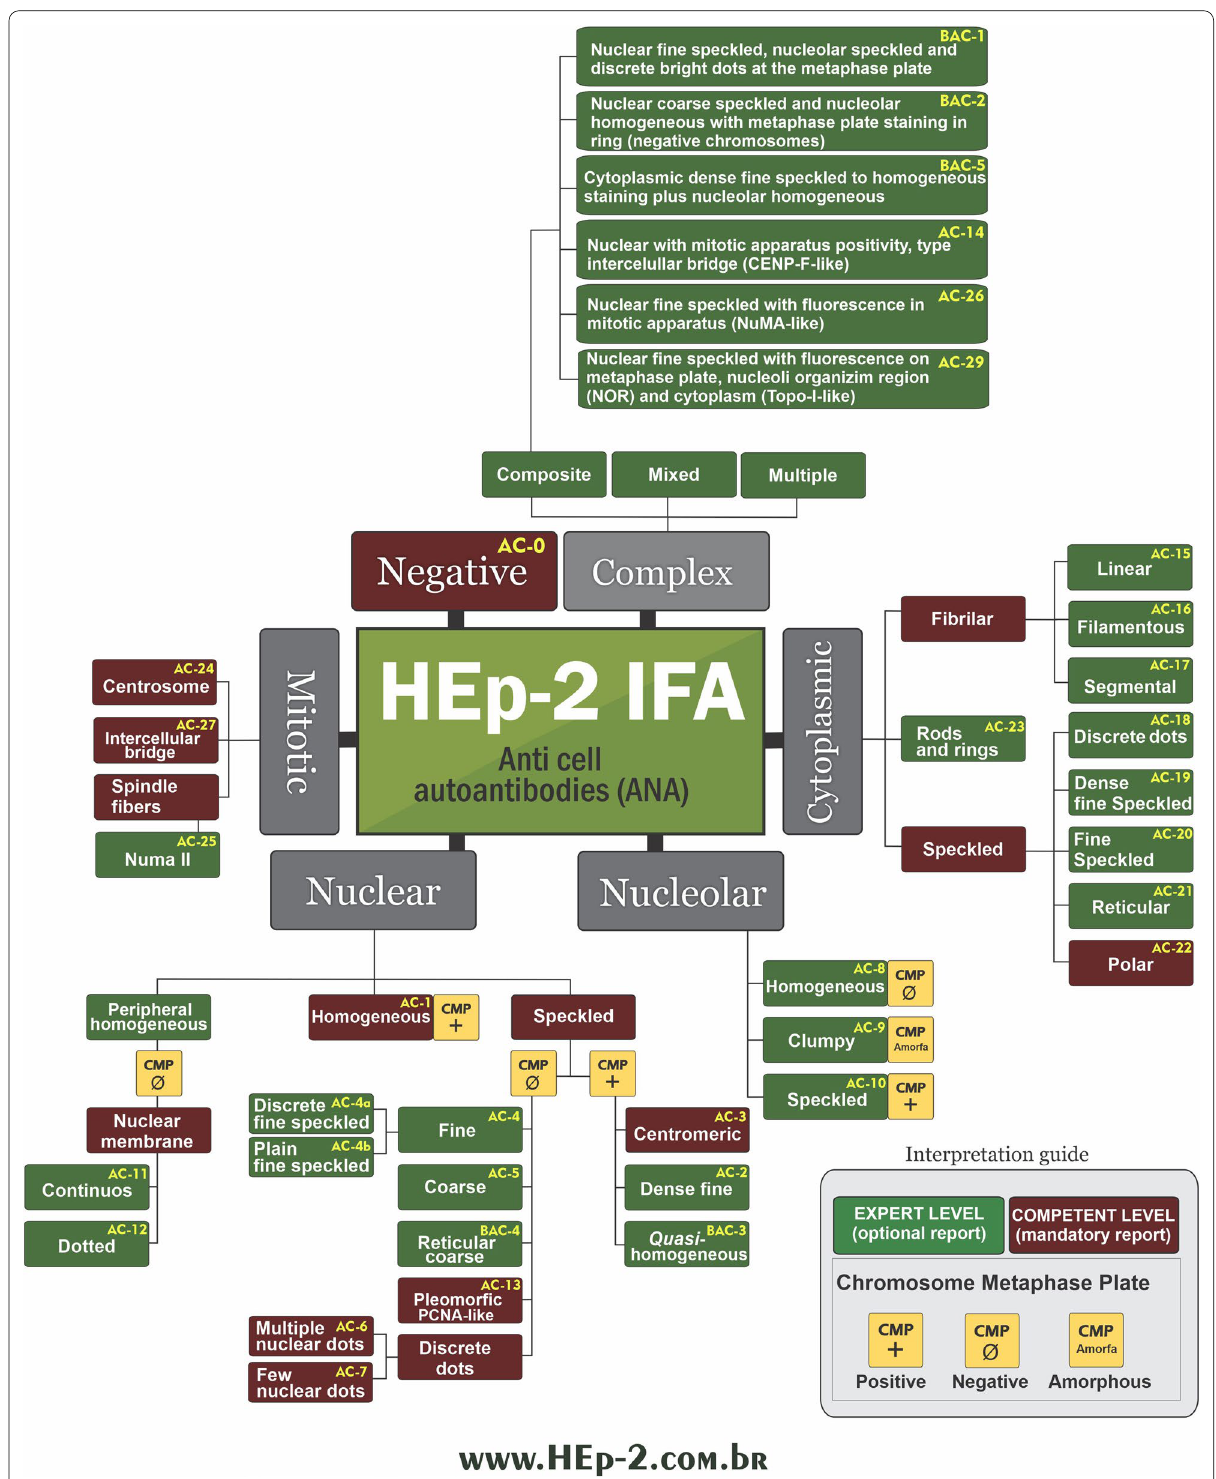
Fig. 2 Brazilian Consensus on ANA Patterns (BCA) classification